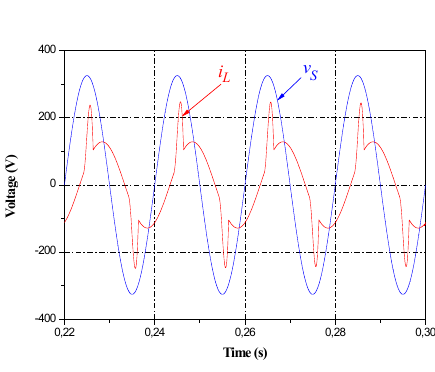
Figure 5. Simulation result of the dc-link regulation of the proposed dc-dc power converter SAPF with reduced dc-link.